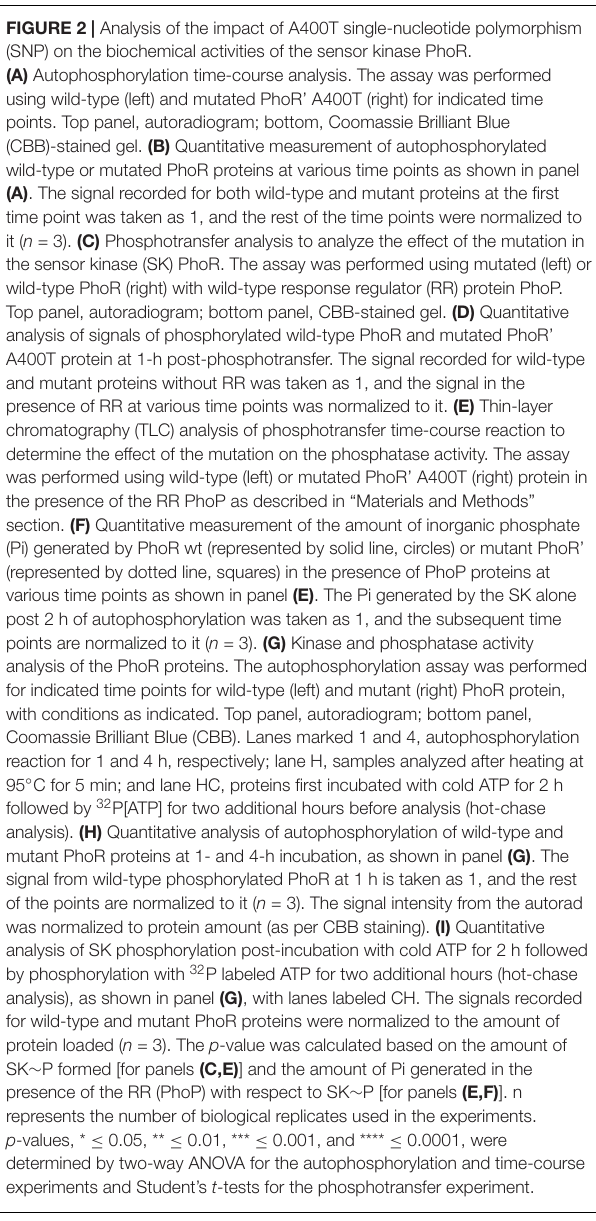
FIGURE 2 | Analysis of the impact of A400T single-nucleotide polymorphism (SNP) on the biochemical activities of the sensor kinase PhoR. (A) Autophosphorylation time-course analysis. The assay was performed using wild-type (left) and mutated PhoR’ A400T (right) for indicated time points. Top panel, autoradiogram; bottom, Coomassie Brilliant Blue (CBB)-stained gel. (B) Quantitative measurement of autophosphorylated wild-type or mutated PhoR proteins at various time points as shown in panel (A) . The signal recorded for both wild-type and mutant proteins at the first time point was taken as 1, and the rest of the time points were normalized to it ( n = 3). (C) Phosphotransfer analysis to analyze the effect of the mutation in the sensor kinase (SK) PhoR. The assay was performed using mutated (left) or wild-type PhoR (right) with wild-type response regulator (RR) protein PhoP. Top panel, autoradiogram; bottom panel, CBB-stained gel. (D) Quantitative analysis of signals of phosphorylated wild-type PhoR and mutated PhoR’ A400T protein at 1-h post-phosphotransfer. The signal recorded for wild-type and mutant proteins without RR was taken as 1, and the signal in the presence of RR at various time points was normalized to it. (E) Thin-layer chromatography (TLC) analysis of phosphotransfer time-course reaction to determine the effect of the mutation on the phosphatase activity. The assay was performed using wild-type (left) or mutated PhoR’ A400T (right) protein in the presence of the RR PhoP as described in “Materials and Methods” section. (F) Quantitative measurement of the amount of inorganic phosphate (Pi) generated by PhoR wt (represented by solid line, circles) or mutant PhoR’ (represented by dotted line, squares) in the presence of PhoP proteins at various time points as shown in panel (E) . The Pi generated by the SK alone post 2 h of autophosphorylation was taken as 1, and the subsequent time points are normalized to it ( n = 3). (G) Kinase and phosphatase activity analysis of the PhoR proteins. The autophosphorylation assay was performed for indicated time points for wild-type (left) and mutant (right) PhoR protein, with conditions as indicated. Top panel, autoradiogram; bottom panel, Coomassie Brilliant Blue (CBB). Lanes marked 1 and 4, autophosphorylation reaction for 1 and 4 h, respectively; lane H, samples analyzed after heating at 95 ◦ C for 5 min; and lane HC, proteins first incubated with cold ATP for 2 h followed by 32 P[ATP] for two additional hours before analysis (hot-chase analysis). (H) Quantitative analysis of autophosphorylation of wild-type and mutant PhoR proteins at 1- and 4-h incubation, as shown in panel (G) . The signal from wild-type phosphorylated PhoR at 1 h is taken as 1, and the rest of the points are normalized to it ( n = 3). The signal intensity from the autorad was normalized to protein amount (as per CBB staining). (I) Quantitative analysis of SK phosphorylation post-incubation with cold ATP for 2 h followed by phosphorylation with 32 P labeled ATP for two additional hours (hot-chase analysis), as shown in panel (G) , with lanes labeled CH. The signals